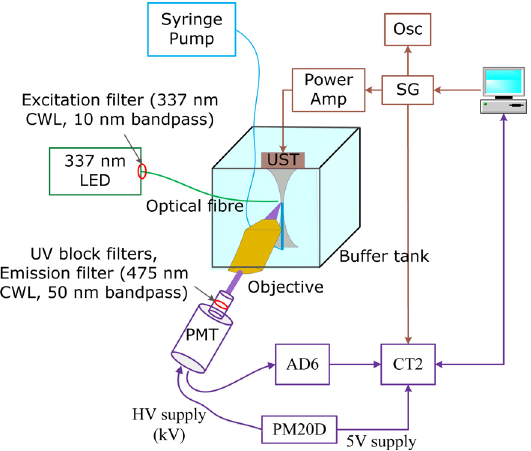
Fig 7. Schematic of the acousto-fluorescence experimental setup. Osc: oscilloscope; SG: signal generator; CWL: center wavelength; PMT: photomultiplier tube; AD6: amplifier-discriminator; CT2: counter/ timer module; PM20D: power supply; HV: high